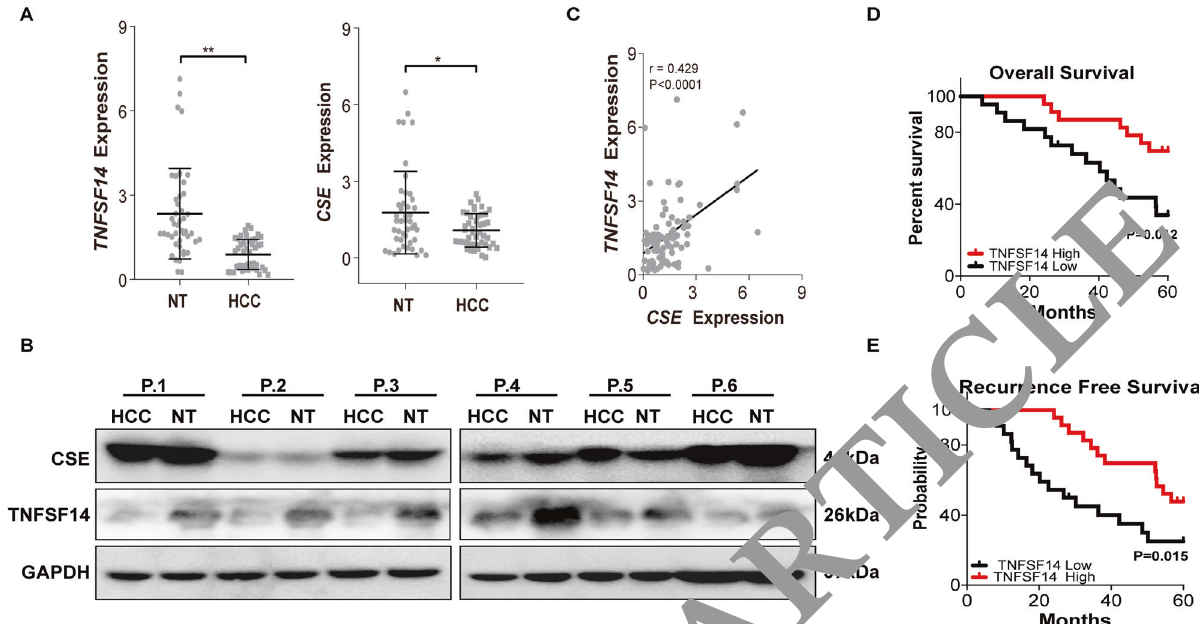
Fig. 6 TNFSF14 expression is associated with the clinical outcome of HCC. A TNFSF14 mRNA and CSE mRNA expression levels in tumorous tissues (HCC; N = 45) and nontumorous tissues (NT; N = 45). B Western blotting analysis for the expression of CSE and TNFSF14 in the tumorous and nontumorous tissues in 6 patients with HCC. C Correlation between CSE mRNA expression levels and TNFSF14 mRNA expression levels in tumorous tissues ( N = 45). D , E Overall survival and disease-free survival curves showed that patients with high expression levels of TNFSF14 have better prognosis. All Bars, ± SD; * P < 0.05, ** P < 0.01, *** P < 0.001, **** P <